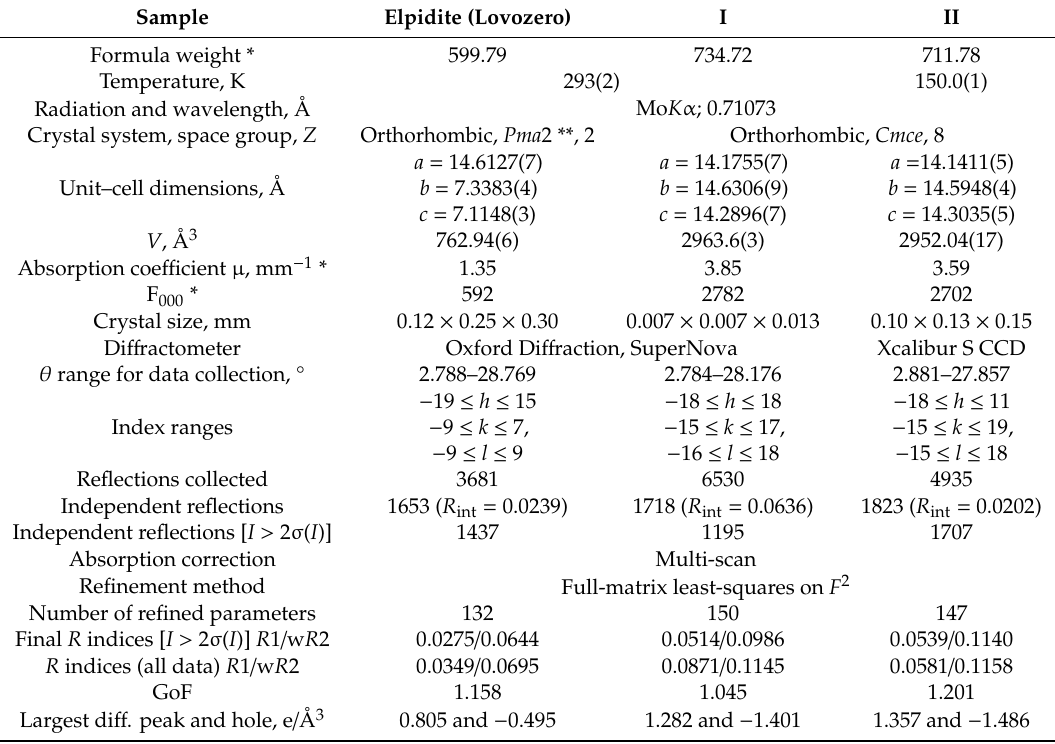
Table 2. Crystal data, data collection information and structure refinement details for elpidite from Lovozero and Ag-exchanged samples I and II